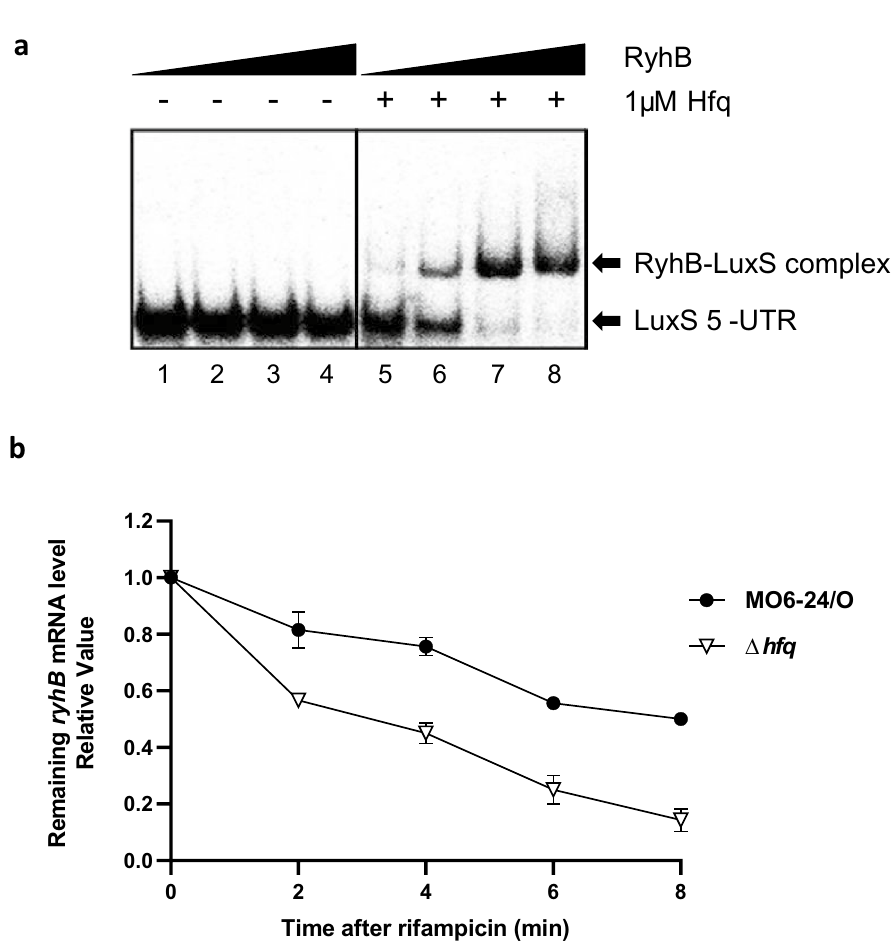
Figure 7. Effects of Hfq on interactions between RyhB and luxS mRNA. ( a ) Gel shift assay comparing the binding of RyhB to luxS mRNA with and without Hfq. The LuxS 5 ′ -UTR was transcribed and labeled with 32 P-UTP using T7 RNA polymerase. Increasing concentrations of purified RyhB were incubated with LuxS 5 ′ -UTR with or without the addition of 1 μM of Hfq. Lanes 1 to 4 include RyhB concentrations of 0, 100, 200, and 400 nM without Hfq, respectively. Lanes 5 to 8 include RyhB concentrations of 0, 100, 200, and 400 nM with Hfq, respectively. The probes bound by RyhB are indicated with arrows. ( b ) Effects of Hfq on the stability of RyhB mRNA. Relative RyhB mRNA levels following rifampicin treatment were measured using qRT-PCR. V. vulnificus MO6 or the hfq mutant (Δ hfq ) were cultured in AB broth for 5 h until reaching an A 600 of 0.3. Samples were then collected at 0, 2, 4, 6, and 8 min after treatment with 500 μg/ml rifampicin for RNA purification and qRT-PCR